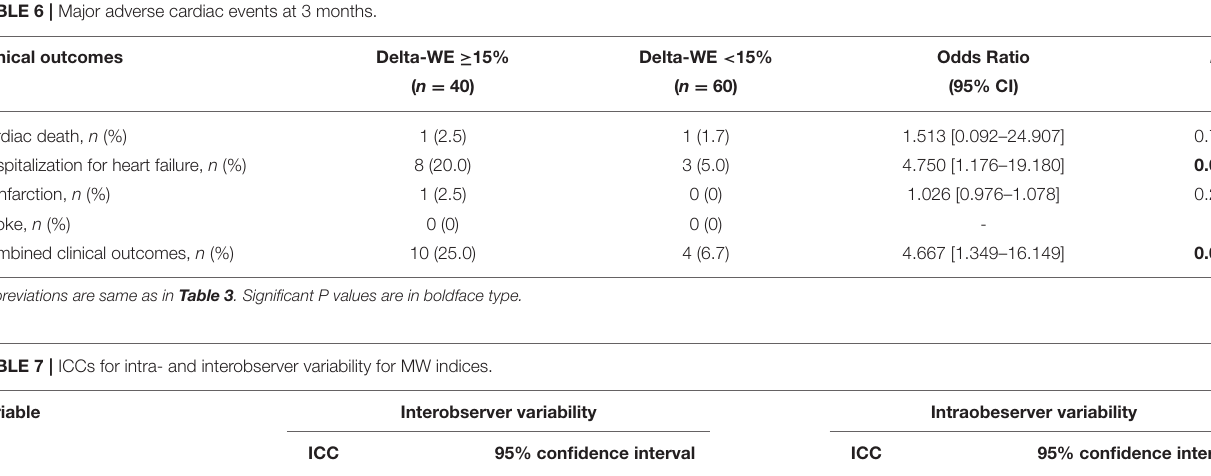
TABLE 6 | Major adverse cardiac events at 3 months.